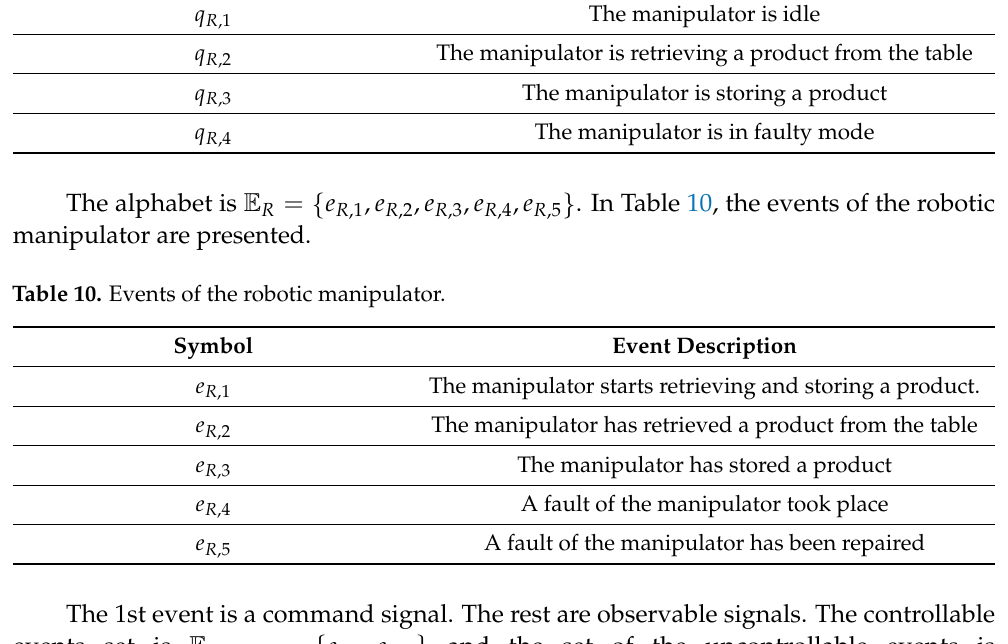
Table 9. States of the robotic manipulator.